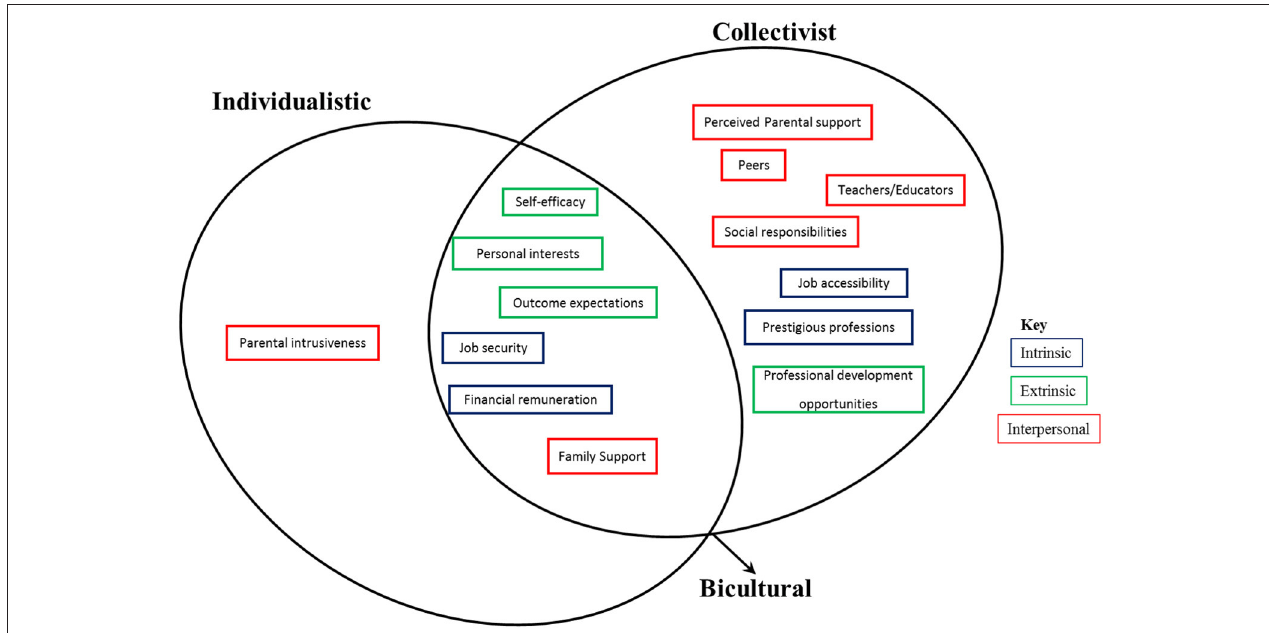
FIGURE 3 | Career influencing factors. The figures shows identified career influencing factors and their distribution in cultural